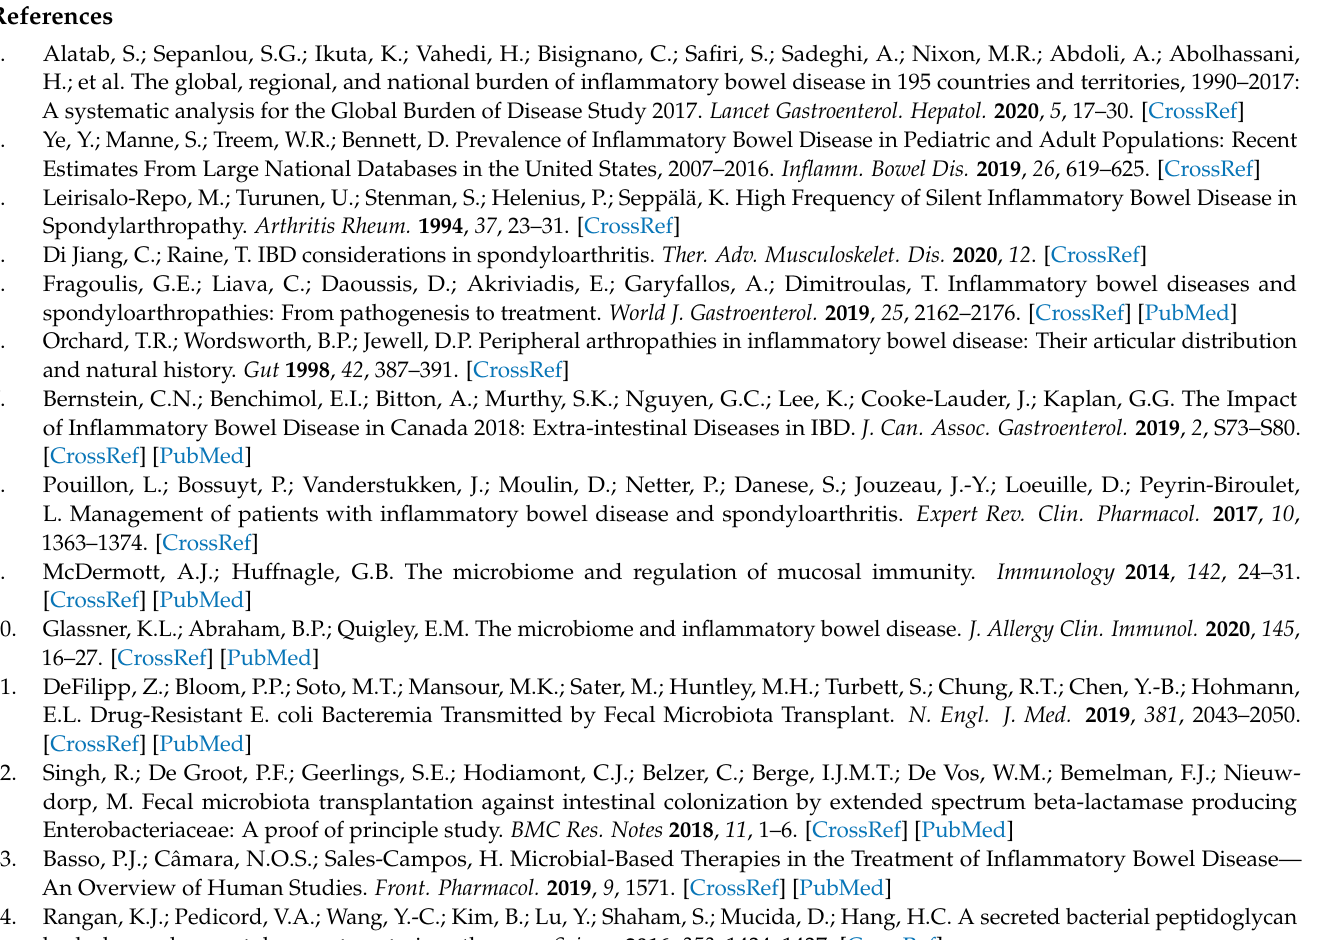
Figure S2: a graphical representation of the mice experiment; Figure S3: human dendritic cells were stimulated with R110, Lactococcus lactis strain at ratio of 1, or left